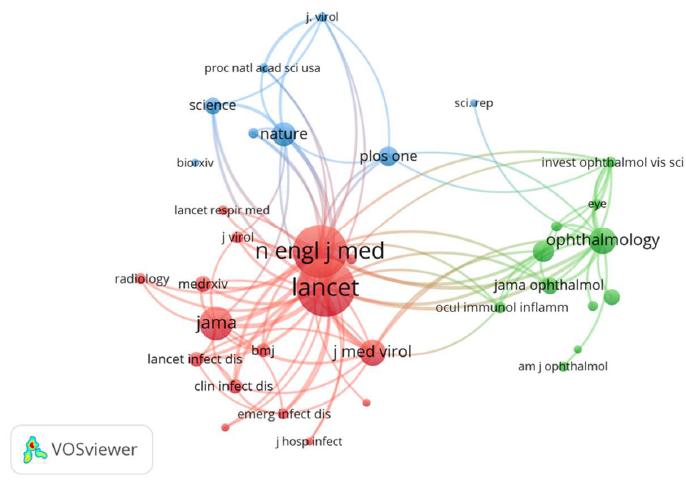
Figure 3. Network visualization map of the co-citation analysis for the journals with published documents about eye-related COVID-19 with a minimum of 150 citations. Journals with the same color are often co-cited.